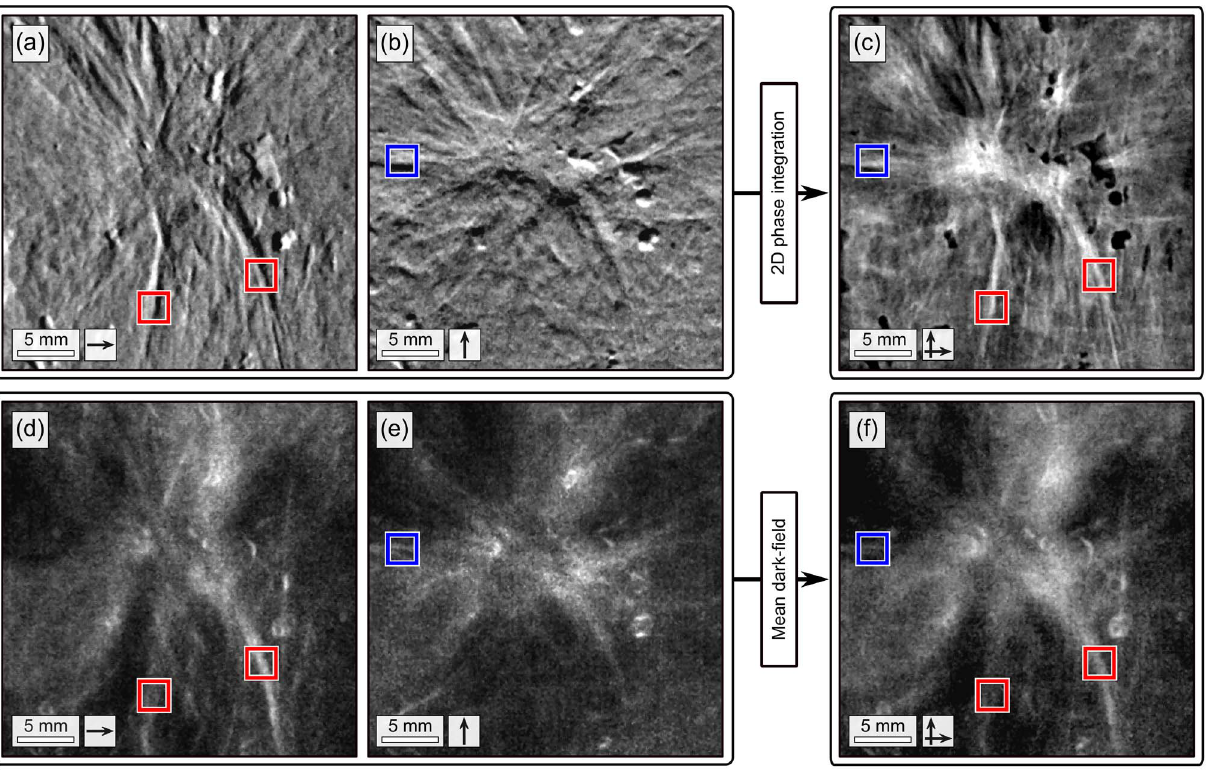
Figure 3. Two-directional, grating-based mammograms of the invasive ductal carcinoma. Two-directional differential phase L w x (a), L w y (b) and sharpened, two-dimensional integrated phase image W s (c). Dark-field D x (d), D y (e) and mean dark-field D image (f). Arrows indicate the direction of scanning. Red and blue boxes indicate tumor branches exclusively perceivable in the images obtained with scanning performed in x - or y -direction, respectively.